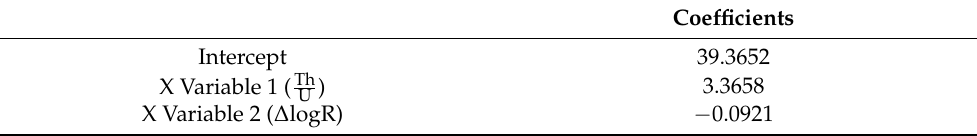
Table 7. Results of multivariate fitting of core TOC, Th/K, and ∆ log R in coal seam.